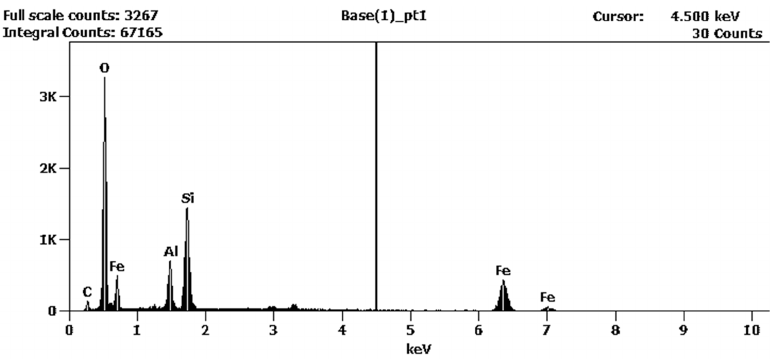
Figure 8. EDS of Point 1 according to Figure 7.